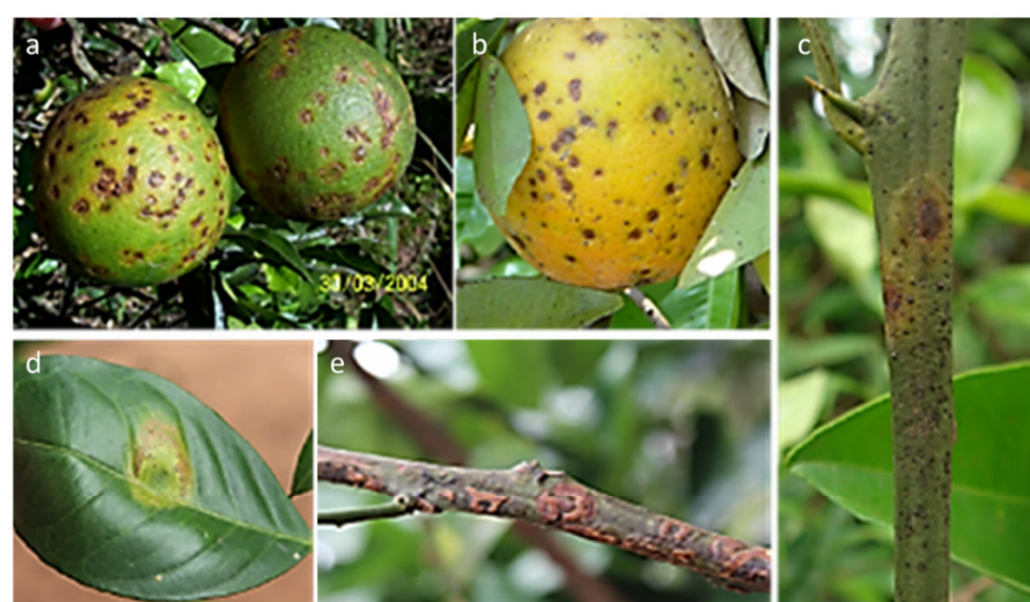
Figure 6. Brown circular lesions surrounded by a chlorotic halo on green fruits of sweet orange trees infected by Satsuma dwarf virus ( a ), a dark depressed lesion on a ripe fruit ( b ), dark and corky bark lesions on the stems ( c , e ), and a circular concentric lesion on a leaf ( d ) (Courtesy of